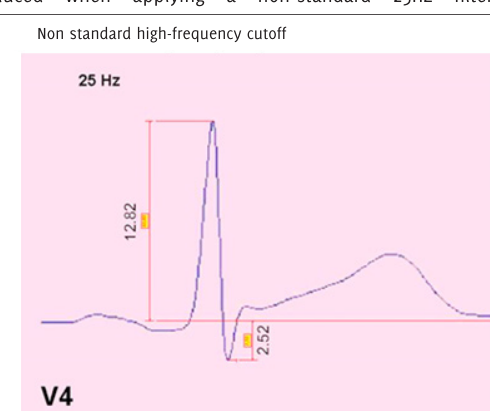
Figure 4. Effect of a high-pass filter in lead V4. Note how the voltages of the R wave (14.84 mm to 12.82 mm) and the S wave (6.68 mm to 2.52 mm) are reduced when applying a non-standard 25Hz filter.